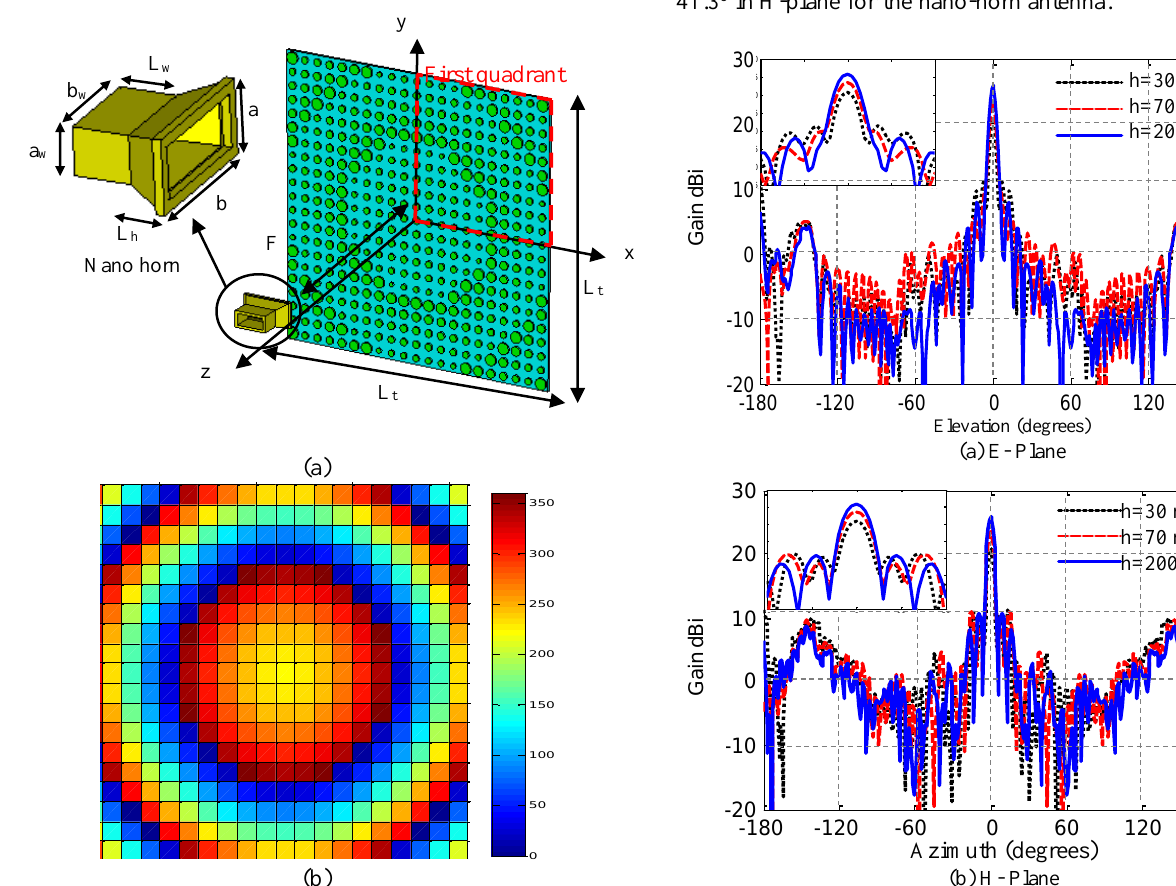
Figure 7 The electric field distribution on the unit-cell with silver supporting plane, h =200 nm, L =350 nm, h d =50 nm and R =130 nm.